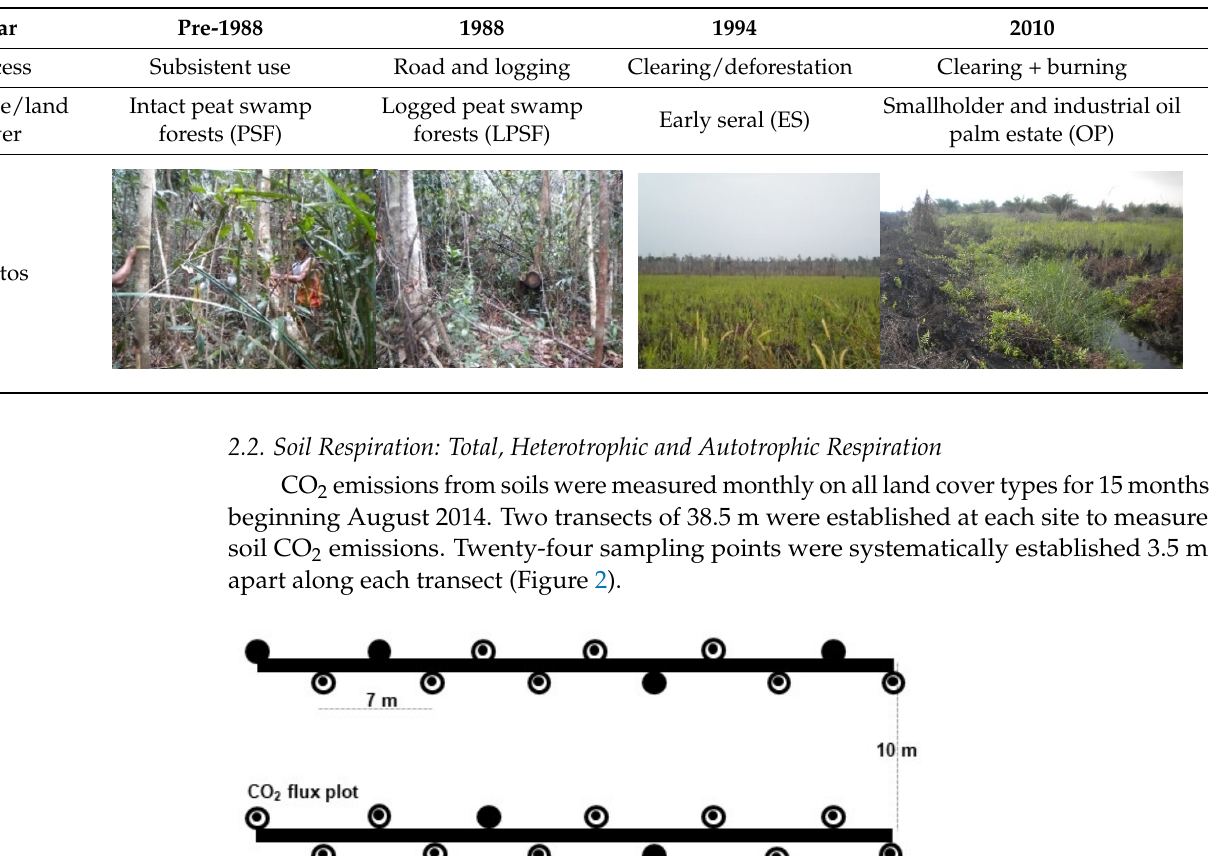
Table 1. Process of historical land use/land cover change in time series that had started since 1988 around the study area. Year Process Land use/land cover